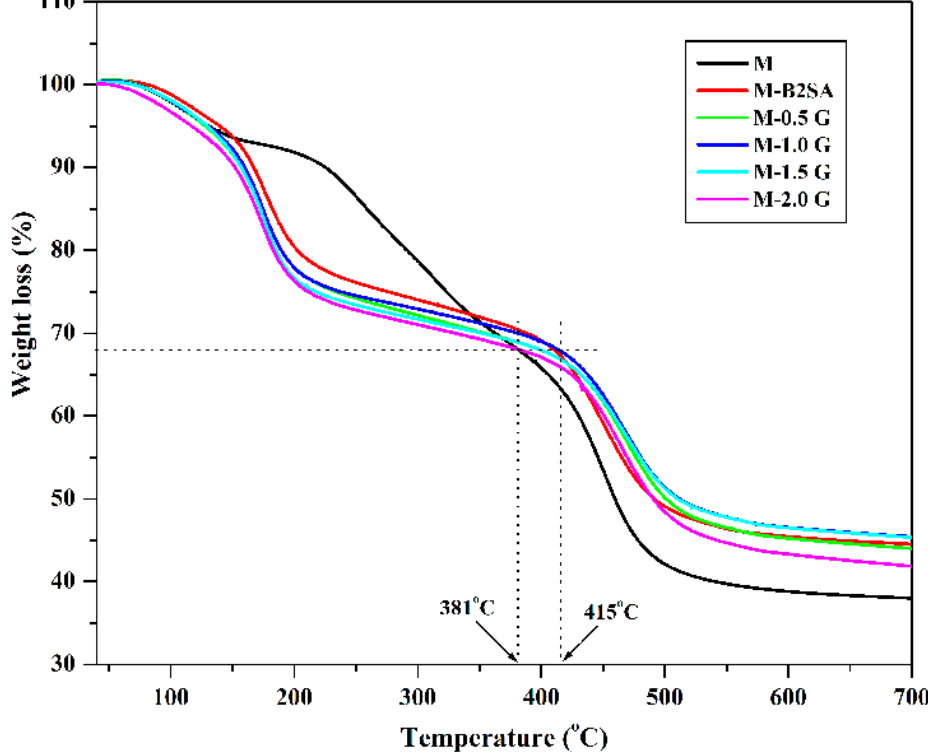
Figure 6. Thermogravimetric analysis patterns of PVA–TEOS (M); sulfonated PVA–TEOS (M-B2SA); and graphene-loaded, sulfonated PVA–TEOS hybrid membranes: (M-0.5 G) 0.5 mass%; (M-1 G) 1 mass%; (M-1.5 G) 1.5 mass%; (M-2 G) 2 mass% of graphene.